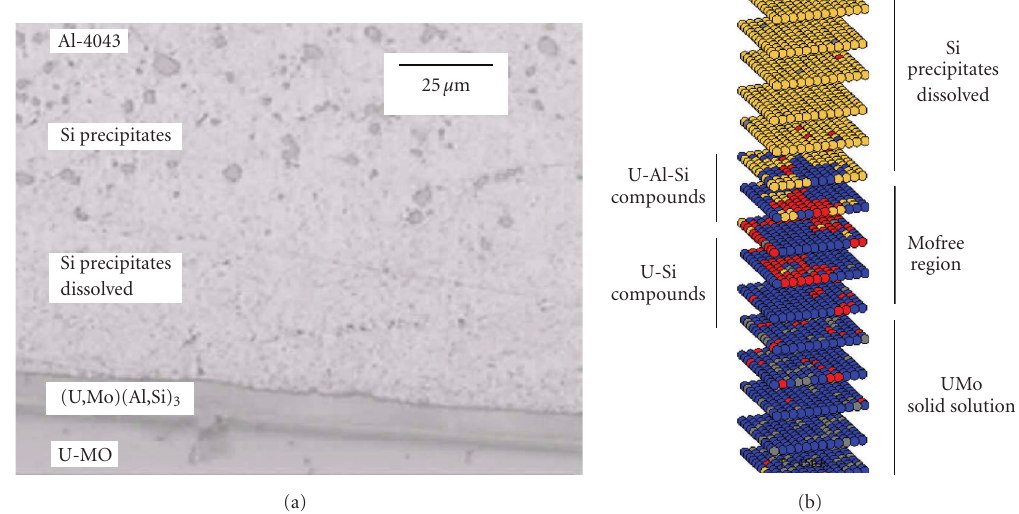
Figure 6: (a) Experimental sample of the Al–5.2wt% Si/U–7 wt% Mo interface showing the zone of depletion of Si precipitates near the interdi ff usion layer [29]. (b) Simulations of the Al-5wt% Si/U-7 wt% Mo interface at T = 500 K showing the main experimental results, such as: (1) Si depletion in Al side, (2) the tendency to local ordering in the zone between Al and U-Mo, and (3) an unexpected interaction between Mo and Si which inhibits the Si di ff usion to deeper layers in the U-Mo solid solution, improving the Si stopping power for Al di ff usion. Al, Si, U, and Mo atoms are denoted with yellow, red, blue, and grey circles, respectively. The experimental result corresponds to a room temperature observation of a sample treated at 550 ◦ C for 2 hours